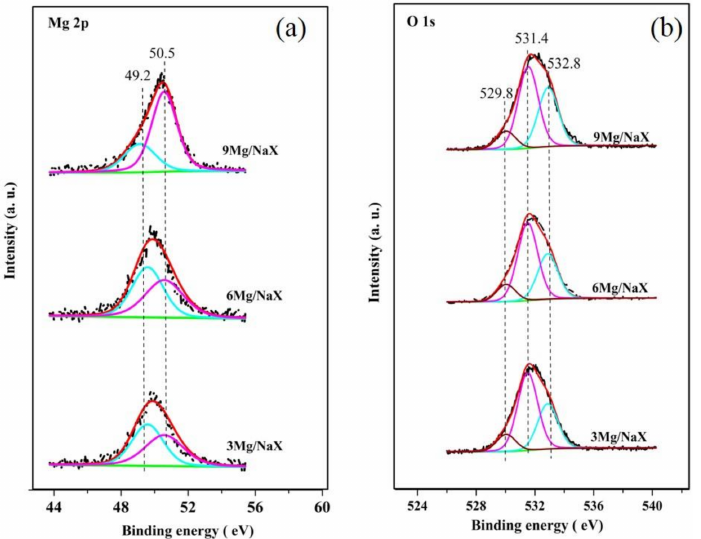
Figure 2. XPS spectra of catalysts with various magnesium contents corresponding to Mg 2p ( a ) and O 1s ( b ).